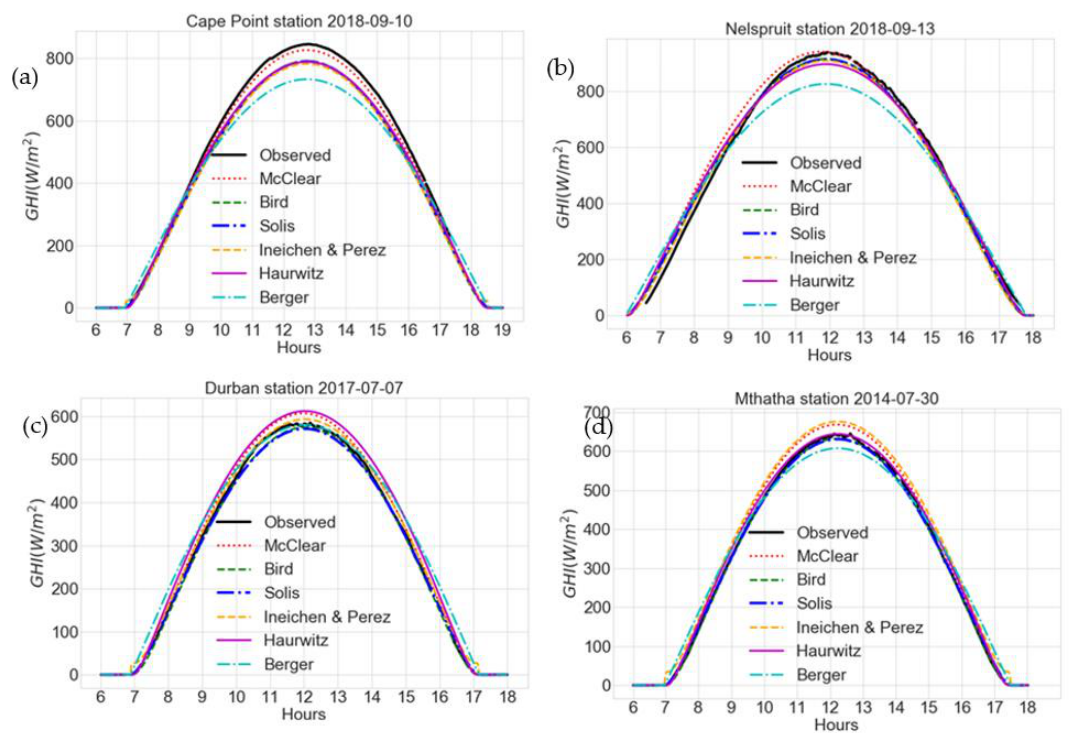
Table 3. Optimum model w.r.t metrics for each station. Figure 7. Comparison between observed and modelled minute GHI values in Mahikeng ( a ), Irene ( b ), Polokwane ( c ), and Thohoyandou ( d ).